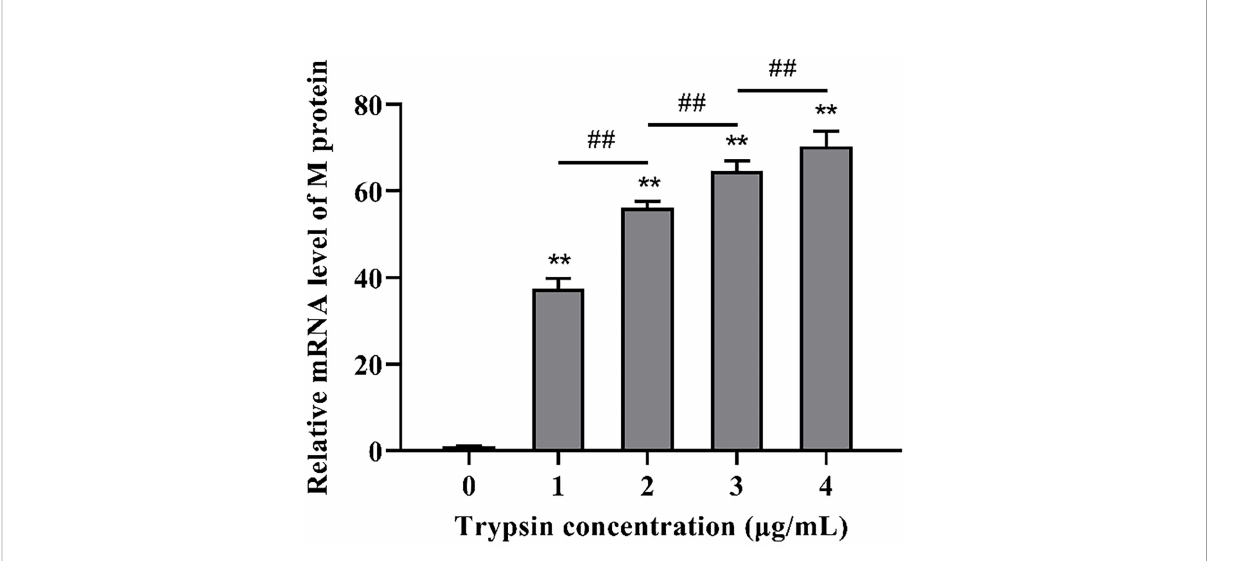
FIGURE 2 Effects of different trypsin concentrations on PDCoV replication. **indicates that the difference is extremely signi fi cant compared with the 0 m g/mL trypsin group (P < 0.01); ## indicates extremely signi fi cant difference ( P < 0.01); No notation indicates that the difference is not signi fi cant ( P > 0.05),